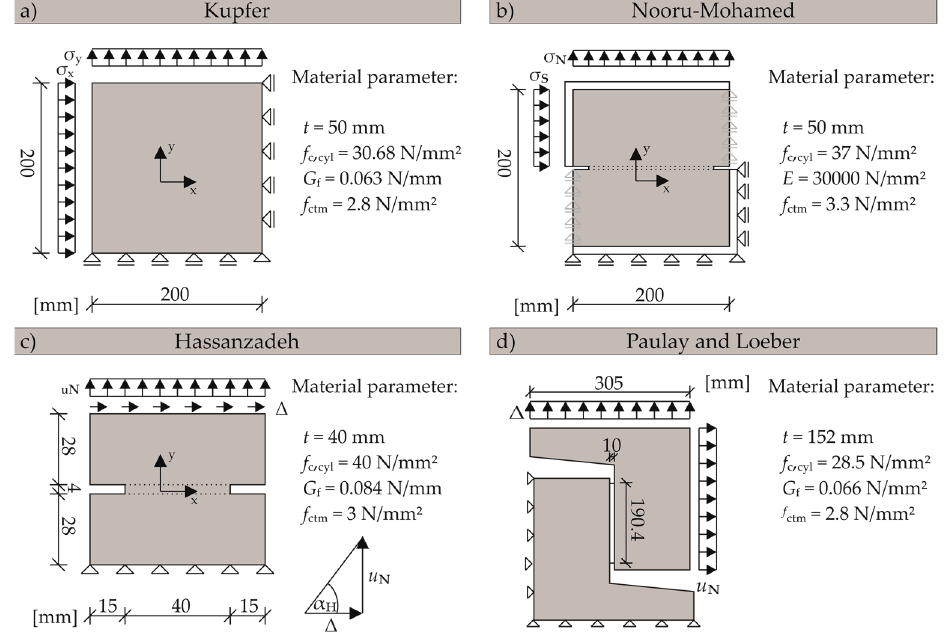
Figure 8. Illustration of the numerical boundary conditions and the material parameters, ( a ) Kupfer et al. [41], ( b ) Nooru-Mohamed [20], ( c ) Hassanzadeh [19] and ( d ) Paulay and Loeber [10].